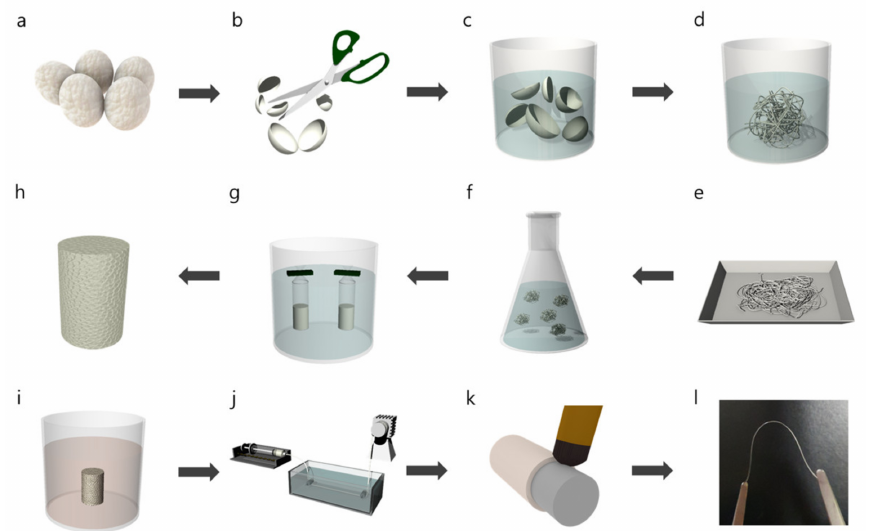
Figure 1. Fabrication process of silk optical fibers. ( a ) Preparing Bombyx mori cocoons. ( b ) Cutting. ( c ) Degumming. ( d ) Removing sericin. ( e ) Drying. ( f ) Dissolving in LiBr. ( g ) Dialysis. ( h ) Freeze- drying. ( i ) Dissolving in HFIP. ( j ) Wet spinning. ( k ) Cladding coating. ( l ) Photo of the silk optical